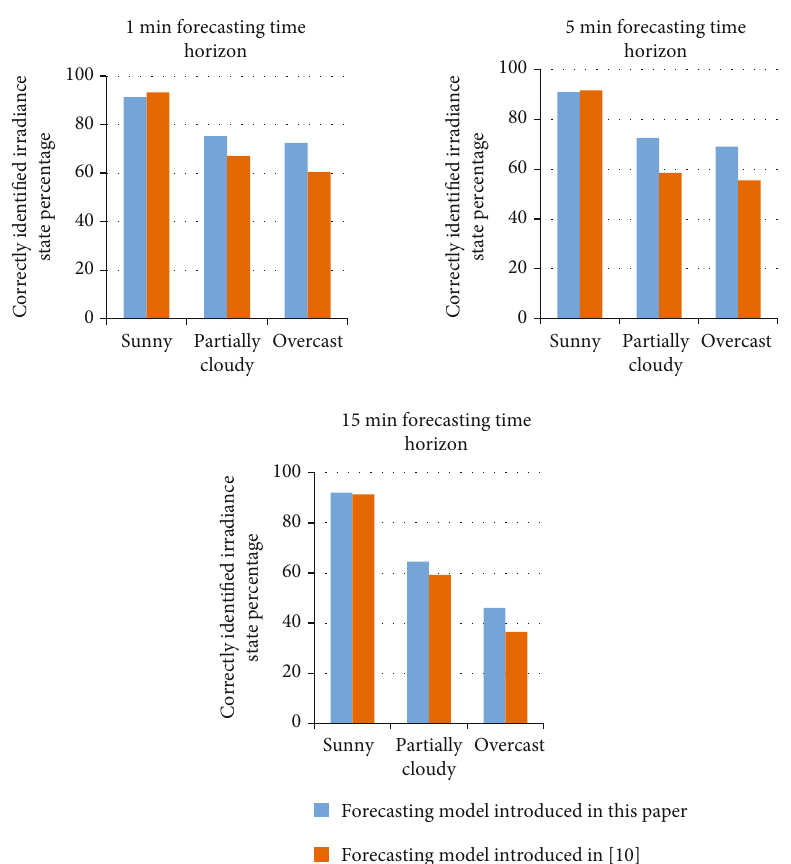
Figure 19: Percentage of correctly identi fi ed true irradiance state by the forecasting model introduced in this paper and by the method in